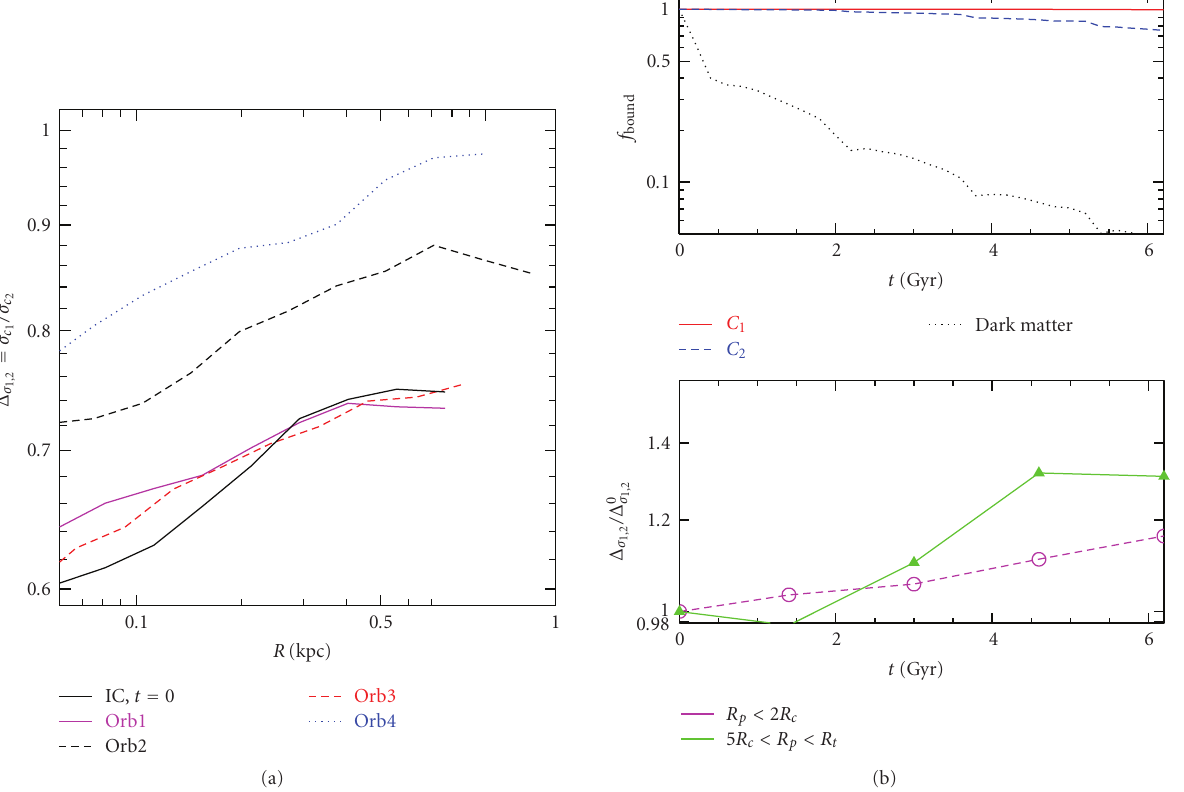
= σ Figure 6: (a) Ratio between the line-of-sight velocity dispersions for component C 1 and C 2 ( Δ σ c 1 /σ c 2 ) as a function of the projected 1,2 distance from the center of the dwarf. The mos distant bin considered has at least 20 particles from each component (and more for for bins closer in). (b) The upper panel shows the fraction of mass (compared to the initial value) that remains bound to the satellite as a function of time for orbit 2. Dotted, red solid and blue-dashed curves are used to indicate the dark matter, and stellar components C 1 and C 2 respectively. In the bottom the evolution with time of the ratio between the velocity dispersions of C 1 and C 2 is shown for two regions within the dwarf: stars within two core radii (magenta dashed) and stars approximately lying closer to the tidal radius (green solid). These ratios have been , thin black line in the right normalized to the original values ( Δ 0 σ 1,2